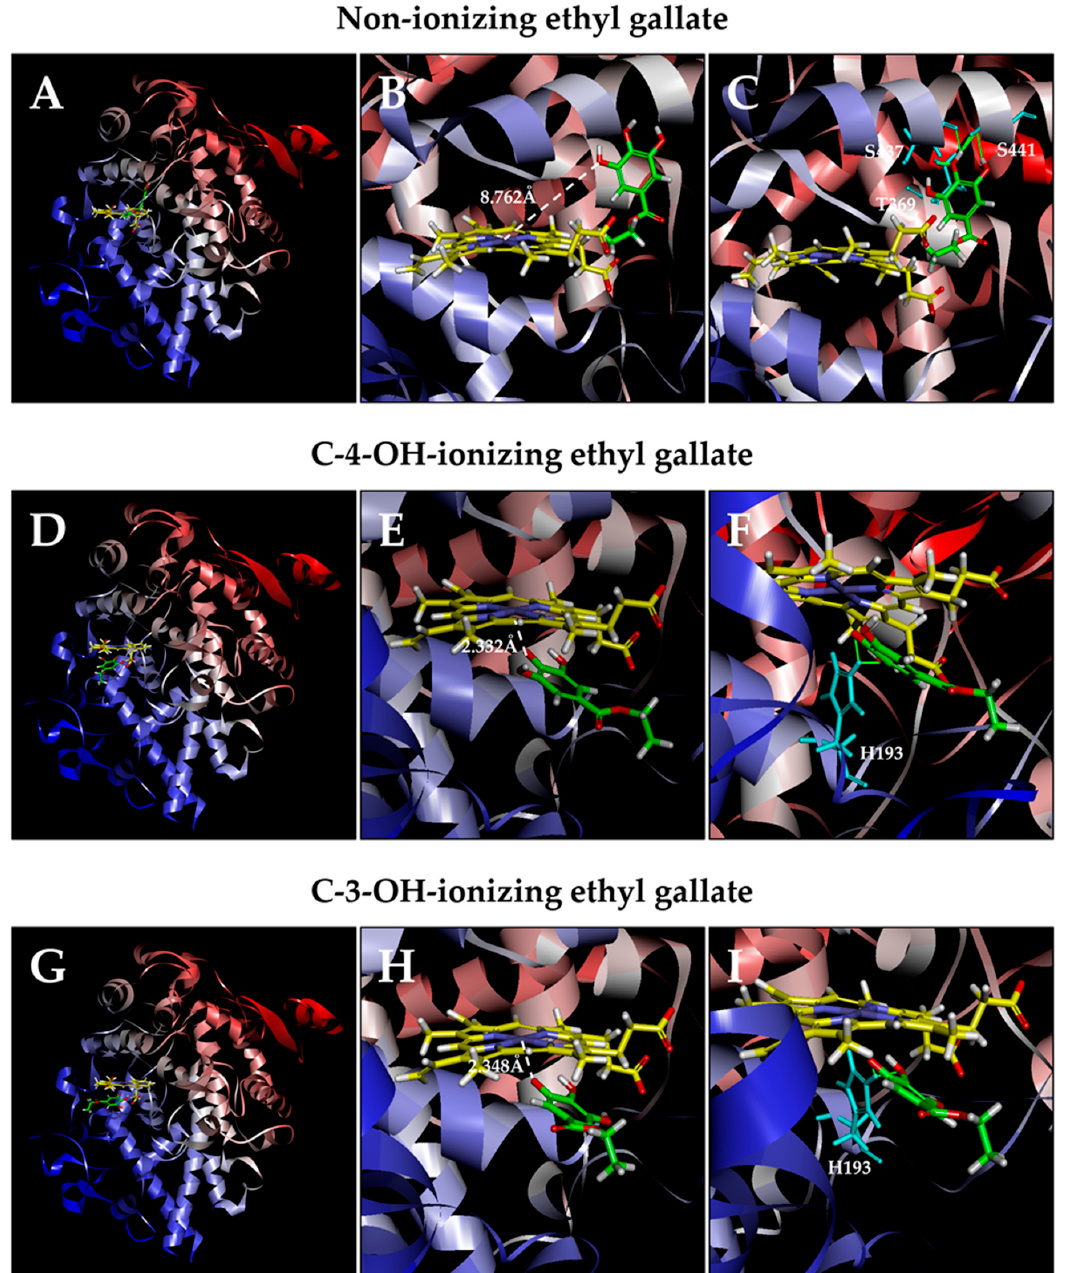
Figure 6. Molecular docking analysis of the binding interaction of ethyl gallate with the peroxidase active site of the COX-2 protein. Panels A , D , and G : The dominant docking result for non-ionizing ( A ), C-4-OH-ionizing ( D ), and C-3-OH-ionizing ( G ) ethyl gallate inside the peroxidase active site of COX-2. The protein structure is shown in a flat ribbon format. In P + Fe IV , carbon is colored in yellow, nitrogen in blue, oxygen in red, hydrogen in white, and iron in bice. In ethyl gallate, carbon is colored in green, oxygen in red, and hydrogen in white. Panels B , E , and H : The same structures as in panels A , D , and G with a white dashed line added to indicate the distance between Fe 4+ ion and O of one of OH groups in ethyl gallate. Panels C , F , and I : Suggested potential hydrogen bonds (green lines) between the non-ionizing ( C ), C-4-OH-ionizing ( F ), or C-3-OH-ionizing ( I ) ethyl gallate and the amino acid residues (His193, Thr369, Ser437, Ser441) in the peroxidase site. The amino acid residues are colored in light blue.